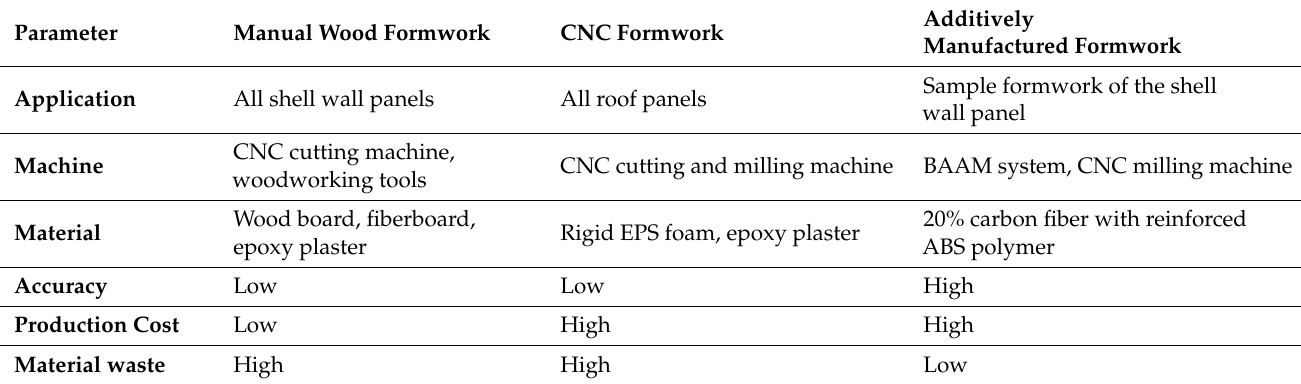
Table 1. Comparison of manual, CNC, and 3D-printed formworks